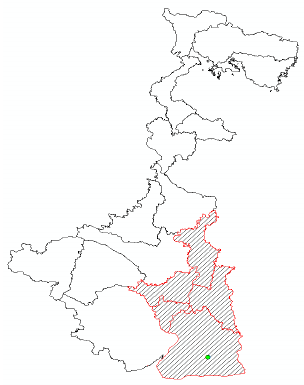
Figure 1: Location of Study area, green color dot indicating the location of the Bonnie